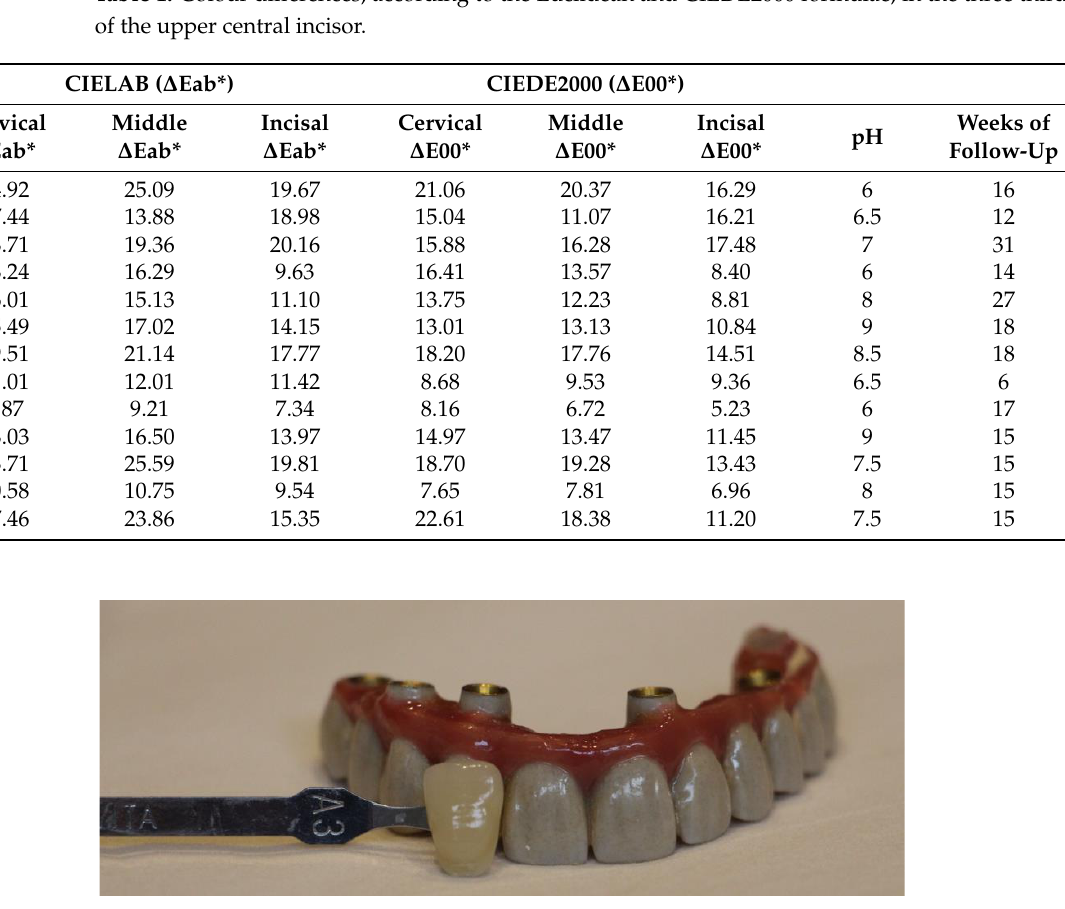
Figure 2. Color difference between A3 dental shade tab and hybrid provisional complete prothesis made of acetal resin. Table 1. Colour differences, according to the Euclidean and CIEDE2000 formulae, in the three thirds of the upper central incisor.